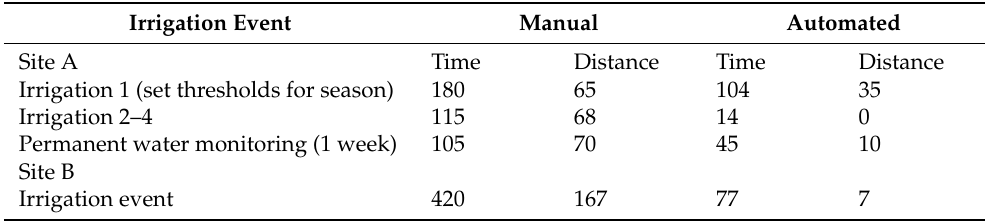
Table 4. Average time taken (minutes) and distance travelled (km) for an individual irrigation event at both sites.